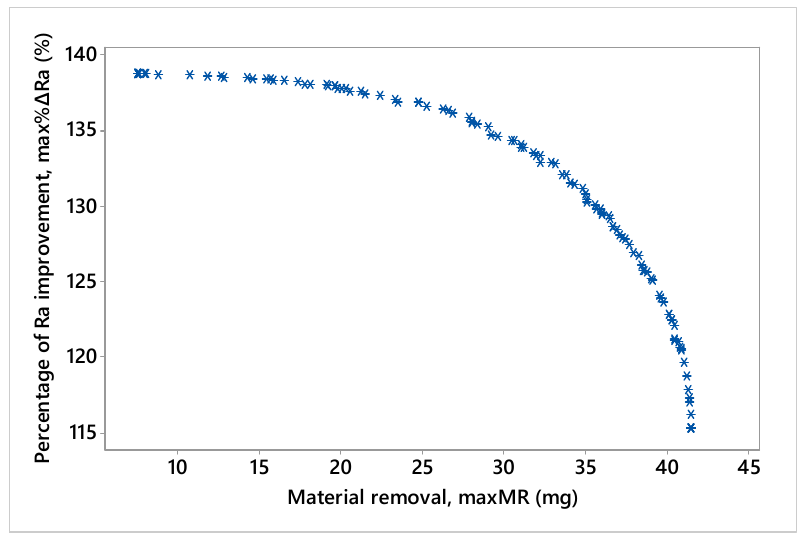
Figure 6. Nondominated Pareto optimal solutions obtained by VEGA for optimizing the rotational-magnetorheological abrasive flow nano-finishing process [4].